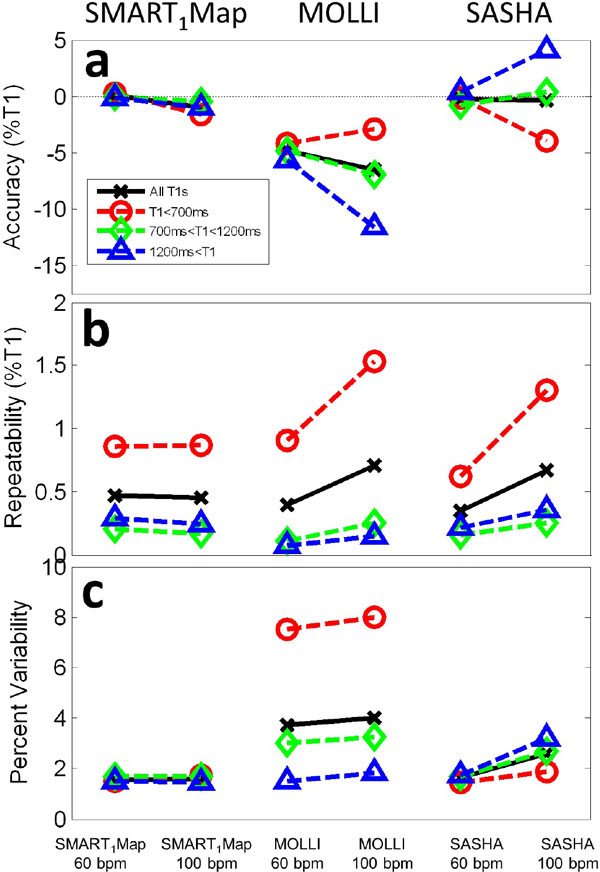
Performance of SMART1Map (left), MOLLI (middle) and SASHA (right) at 60 and 100 bpm showing a) average accuracy of mean T1s over each of the 22 ROIs, b) repeatability of mean T1s over 10 repeats, and c) pixel-wise variability of measured T1 values within each sample. All data are reported as a percentage of reference T1 values from IR-spin echo. Data are shown for 4 cases: i) averaged across all T1s (black line); ii) T1 < 700 ms (red, typical of post-contrast myocardium); iii) 700 < Y1 < 1200 ms (green); and iv) T1>1200 ms (blue, typical of native myocardium).